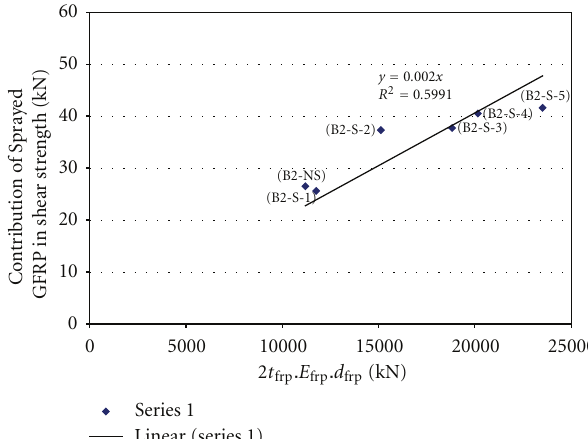
Figure 40: Contribution of Sprayed GFRP in shear strength versus 2 × t frp × E frp for RC beams strengthened by Sprayed GFRP on two sides with no mechanical fasteners and no